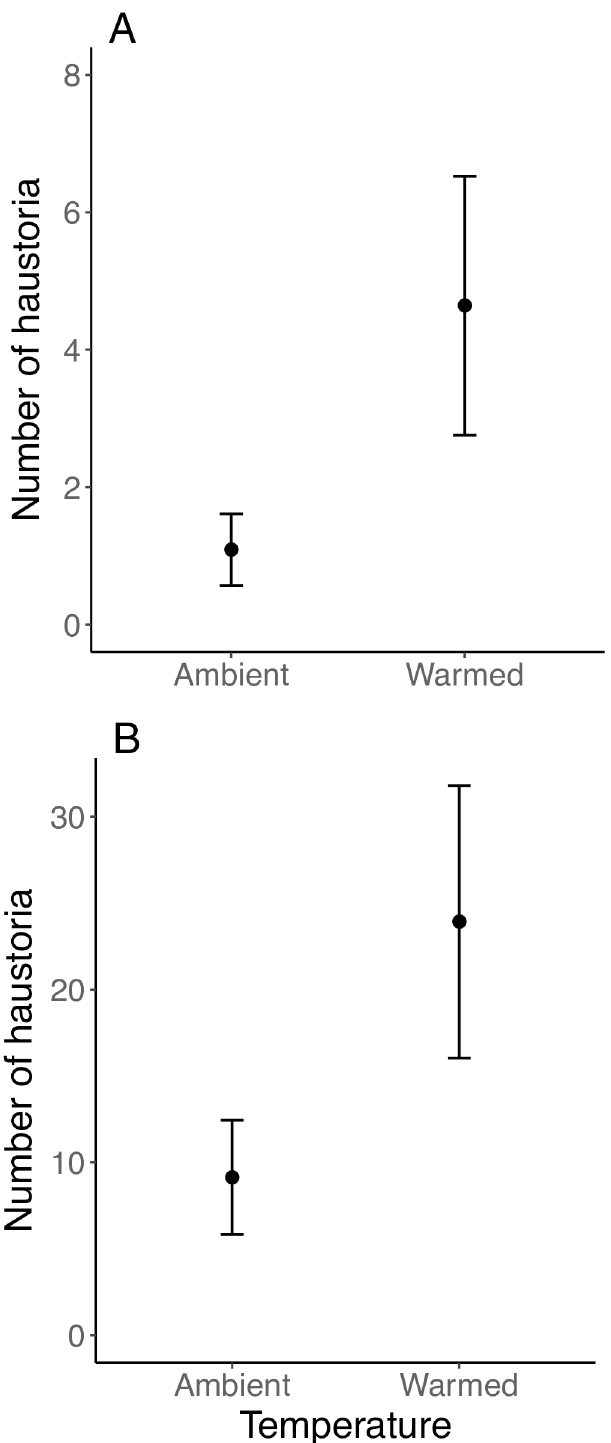
Fig 2. Mean number of haustoria ( ± SE) by temperature treatment for (A) all hemiparasite plants grown with a host plant (ambient: n = 59, warmed: n = 54) and (B) only those hemiparasite plants that produced at least one haustorium when grown with a host plant (ambient: n = 8, warmed: n =